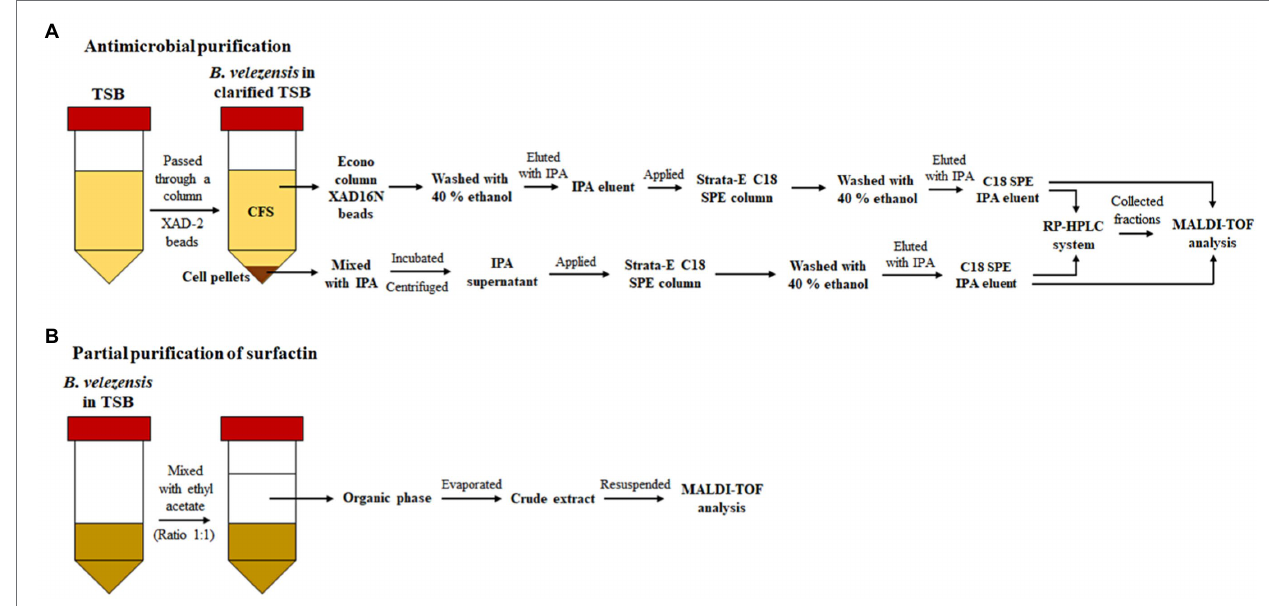
FIGURE 1 | Schematic representation of antimicrobial purification by (A) RP-HPLC and (B) by solvent extraction assay (for the partial purification of